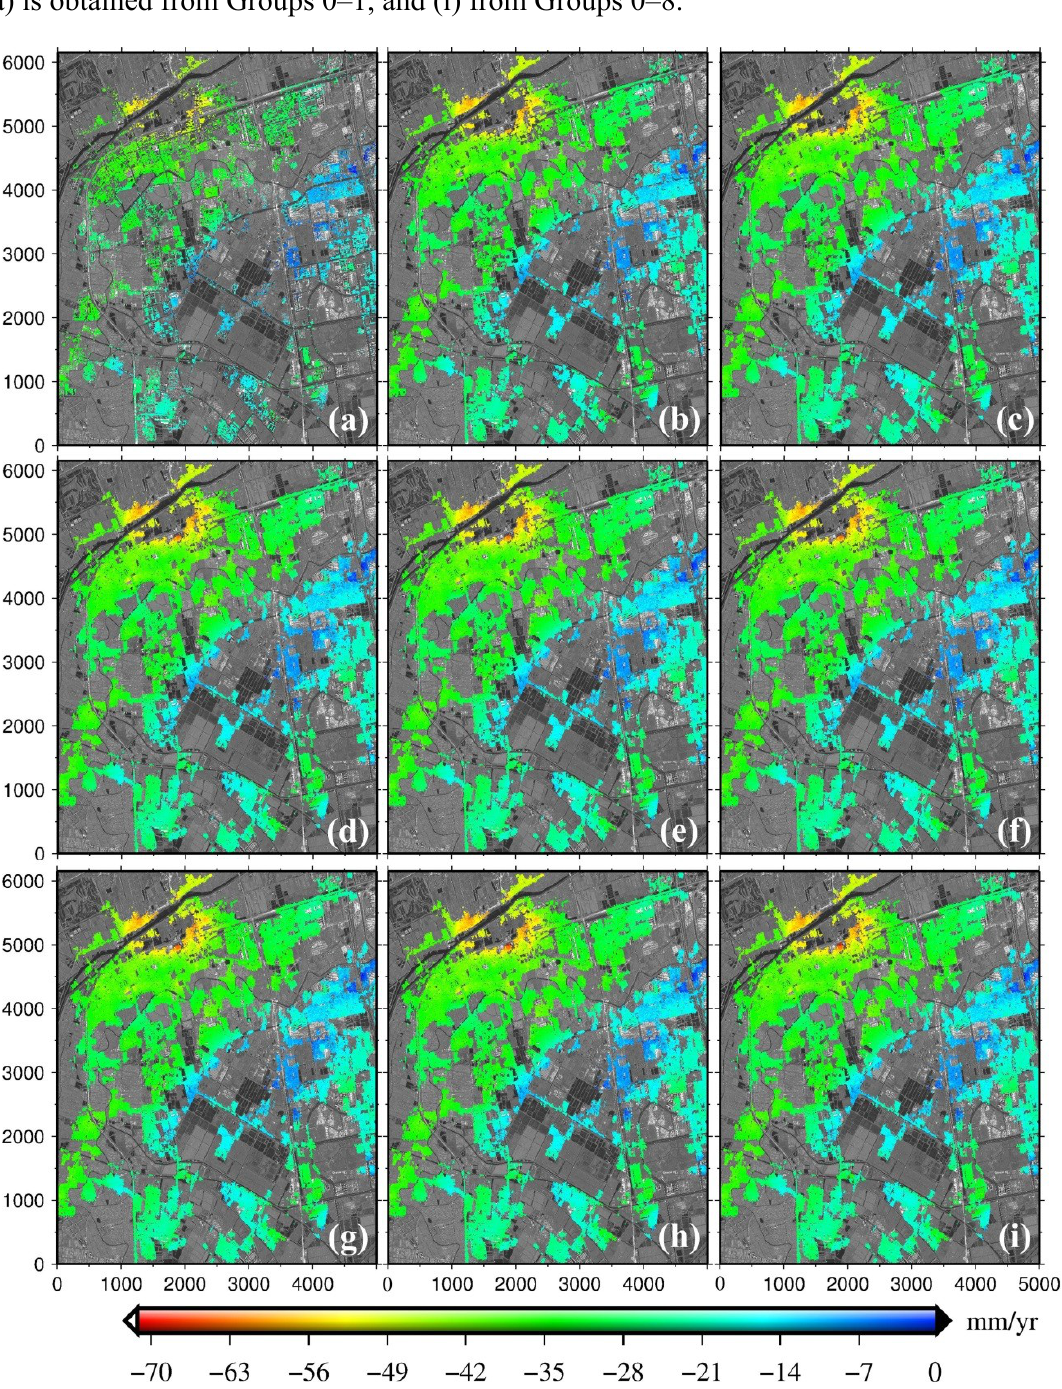
Figure 6. The subsidence rates expanded for the study area. ( a – i ) depicts the combined subsidence rates obtained from the previous and current groups, respectively. For